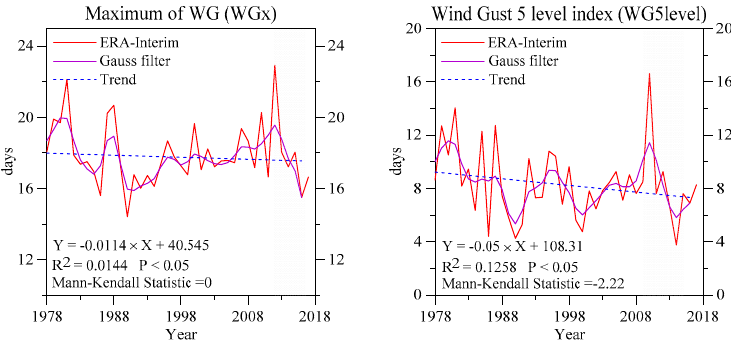
Figure 9. Time series of area ‐ averages wind gust indices (WGx and WG5level, and the gray area indicates a more significant variability) during the period 1979–2017 based on ERA ‐ Interim Reanalysis data.